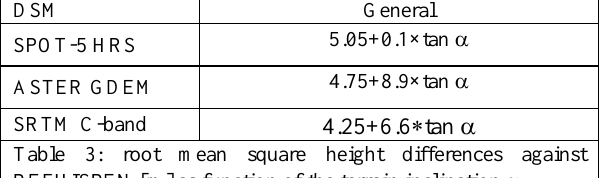
Table 3: root mean square height differences against